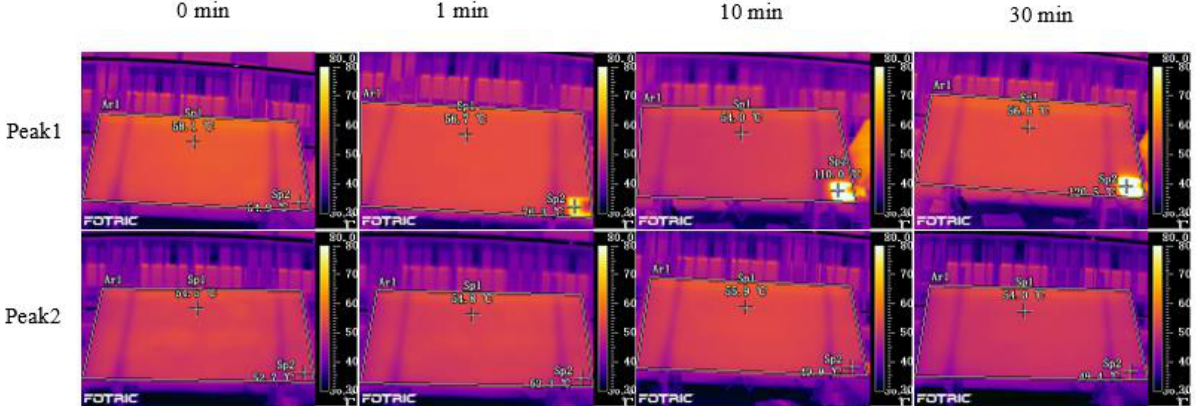
Figure 6. IR image of the PV module when working at the LMPPs (SP1 is the temperature of the solar cell with normal irradiance, SP2 is the temperature of the shadowed solar cell).